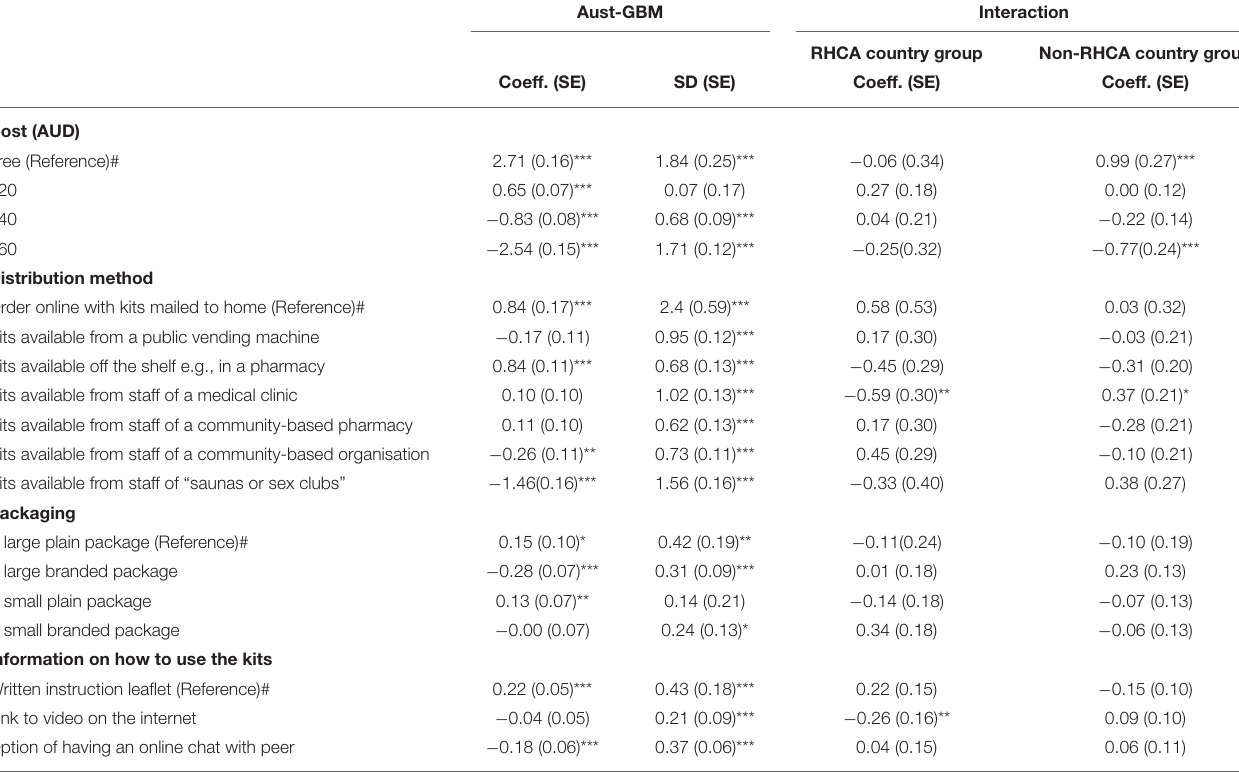
TABLE 3 | Preferences for HIV self-testing distribution (DCEKits) using the mixed logit model.